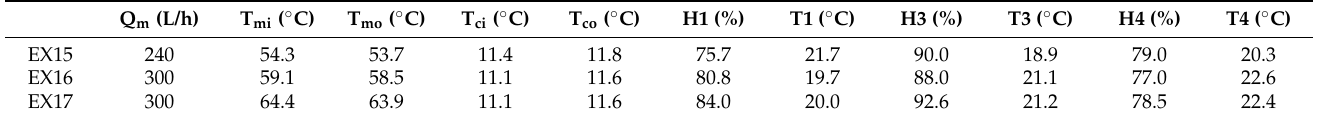
Table 8. Measured temperatures and humidity for MM006.